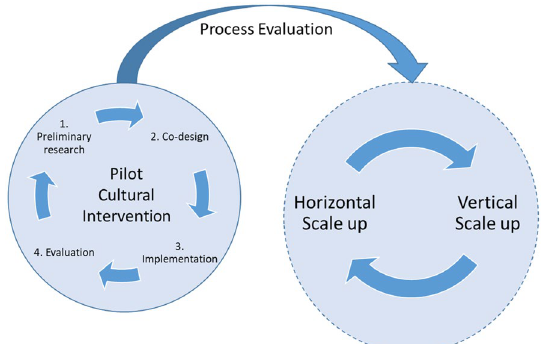
Fig. 1 Cultural Intervention for Burnout: from pilot project to scaling up. Source: Authors’